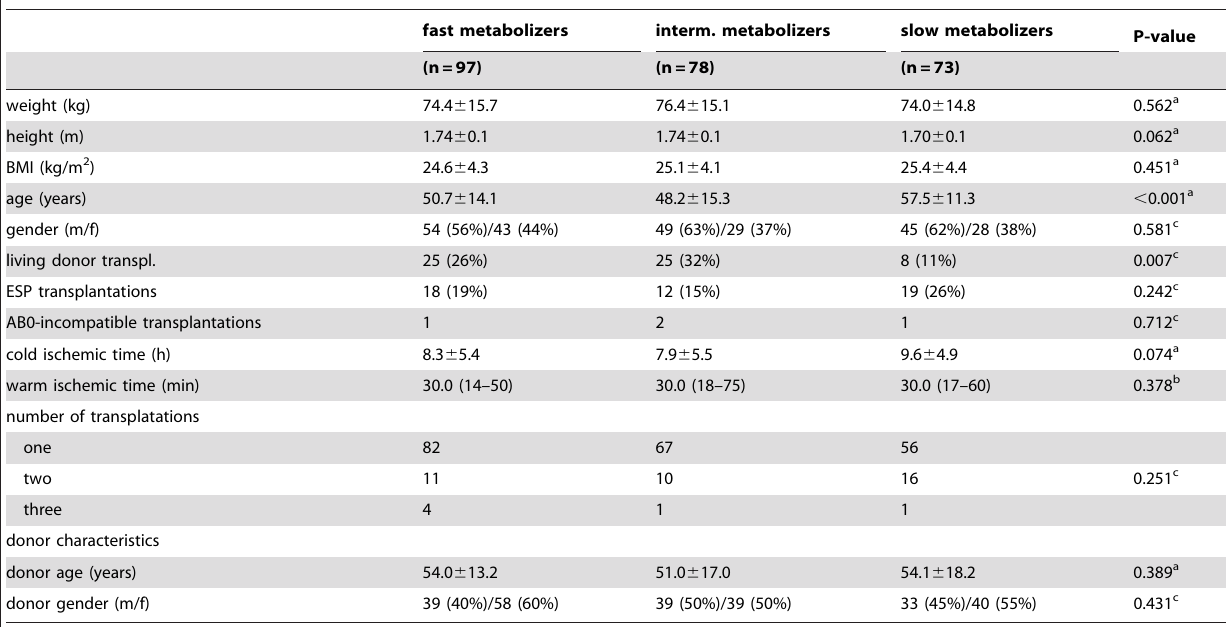
Table 1. Patients characteristics.